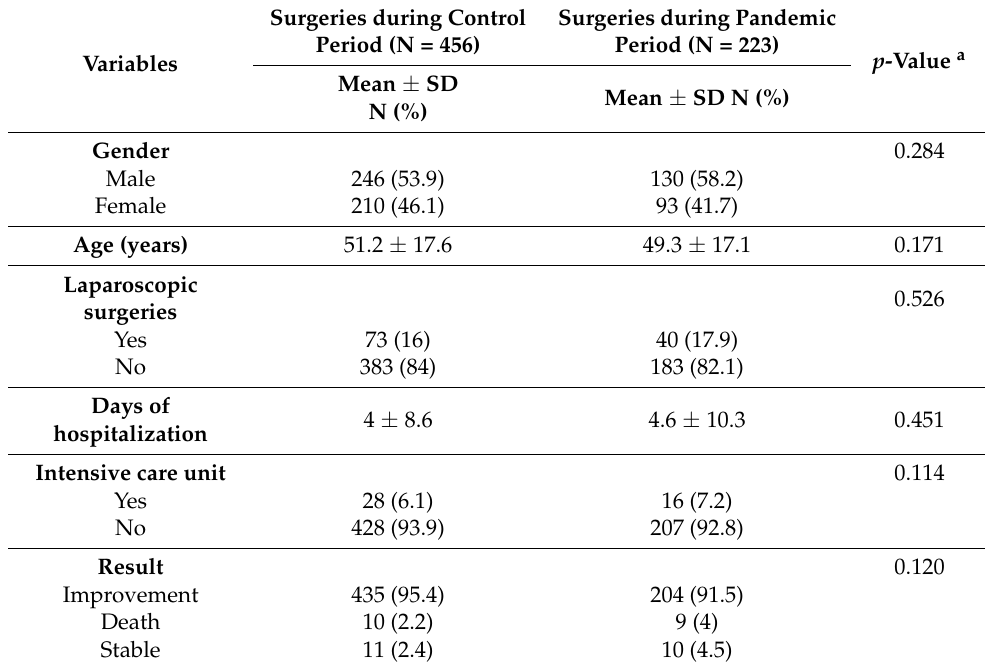
Table 1. Characteristics of the surgeriesduring the control and pandemic periods.